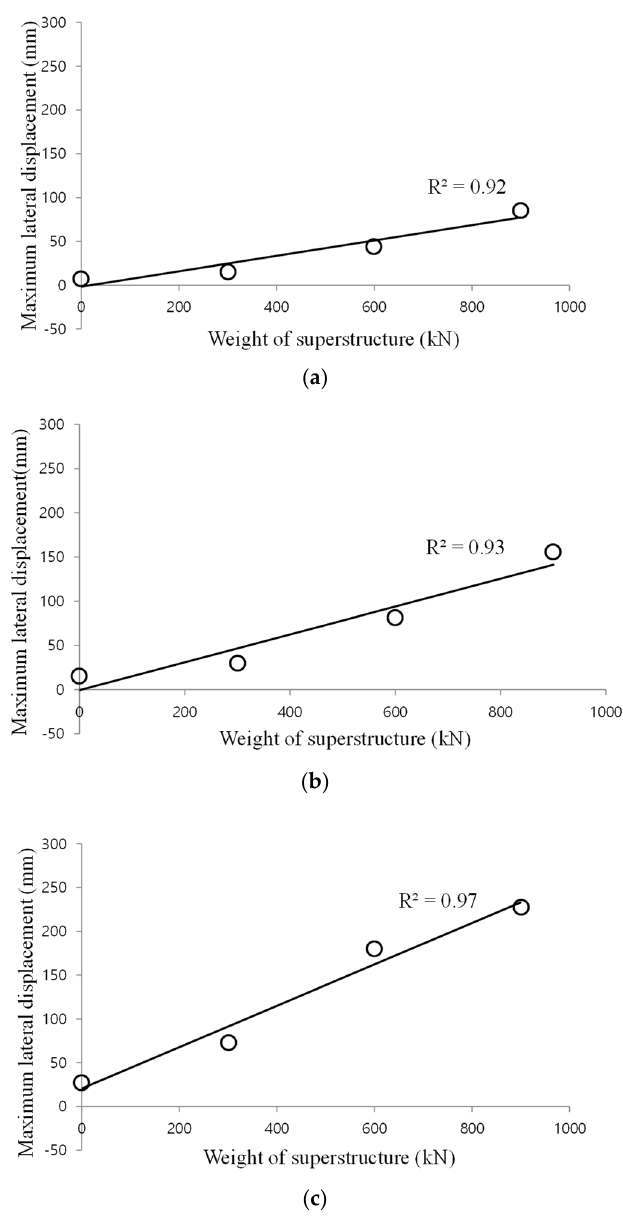
Figure 14. Relationship between weight of superstructure and maximum lateral pile displacement. ( a ) Input acceleration: 0.13 g; ( b ) Input acceleration: 0.25 g; ( c ) Input acceleration: 0.45 g.